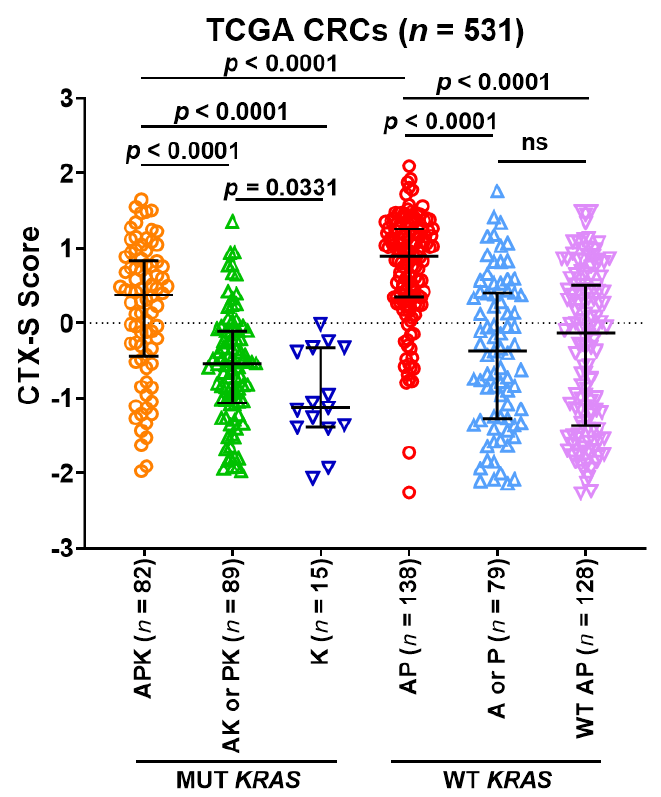
Figure 4. Comparison of CTX ‐ S scores among six subgroups of MUT vs. WT APC/TP53/KRAS in TGGA CRC tumors. Here, A—Mut APC ; P—Mut TP53 ; K—Mut KRAS ; WT AP—both APC and TP53 wild ‐ type. Bars represent median with interquartile range. p values are for two ‐ tailed Welch t test.